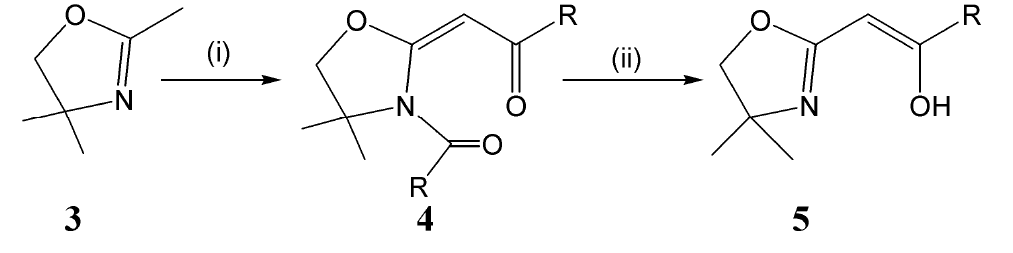
Sometime ago, Tohda and co-workers presented [22] a facile two-step strategy for the synthesis of enol-containing oxazolines initiating from 2,4,4-trimethyl-2-oxazoline ( 3 ). This protocol (Scheme 1) involves the ( i ) treatment of 3 with base (NEt alkoyl-chloride to yield an intermediate ethanone. This latter compound is then hydrolysed with excess alcoholic base ( ii ) to yield the desired enol-oxazoline product ( 5 : Scheme 1). Materials such as 4 have found application in the production of other heterocycles [23] and as general synthetic intermediates [24-27]. A compound of general formula 4 (Scheme 1) has not previously been the subject of study via single crystal X-ray diffraction. In this report, we detail the solid-state properties of an example of crystalline 4 in which the R group (Scheme 1) is –C Scheme 1. The synthesis of enol-oxazolines ( 5 ) according to the method of Tohda [22]; specific conditions to yield 4 : ( i ) 2 × p -MeO-C